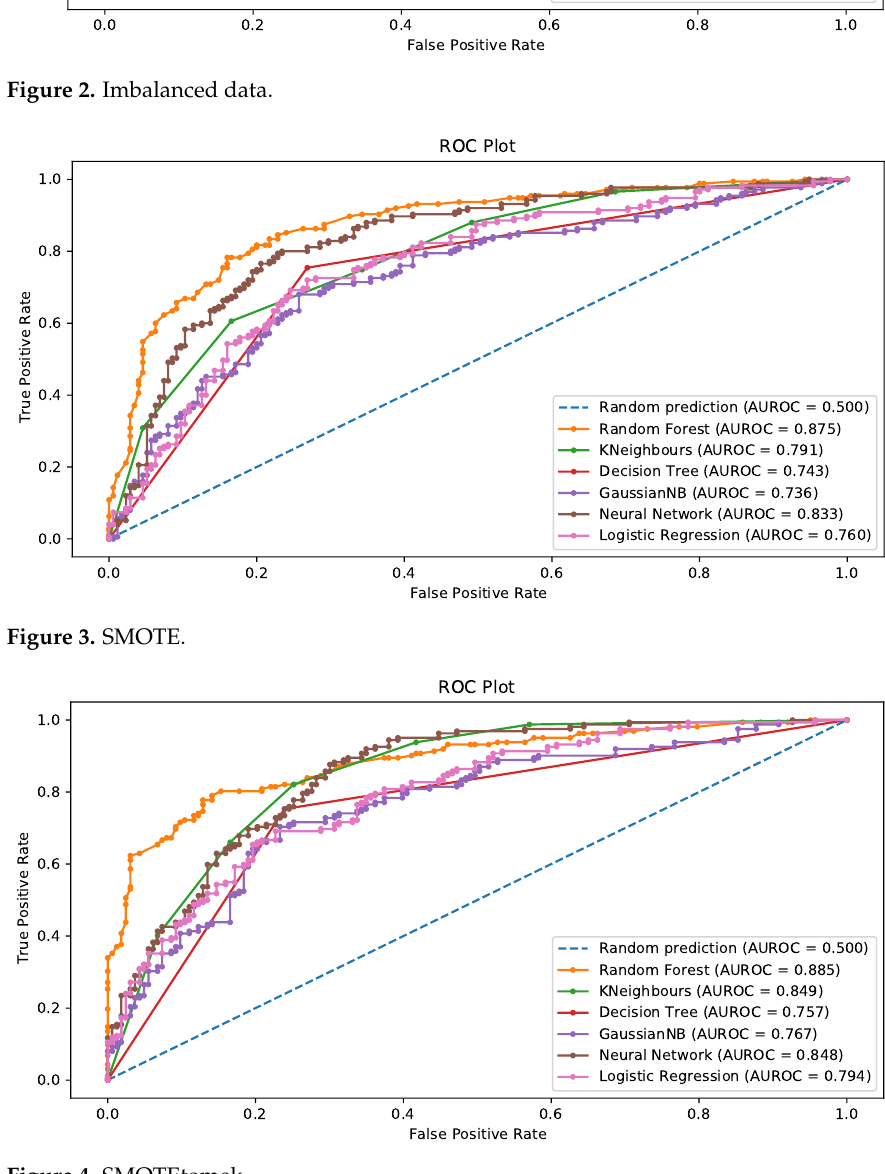
Random prediction (AUROC = 0.500) Random Forest (AUROC = 0.755) KNeighbours (AUROC = 0.714) Decision Tree (AUROC = 0.598) GaussianNB (AUROC = 0.795) Neural Network (AUROC = 0.735) Logistic Regression (AUROC = 0.782)